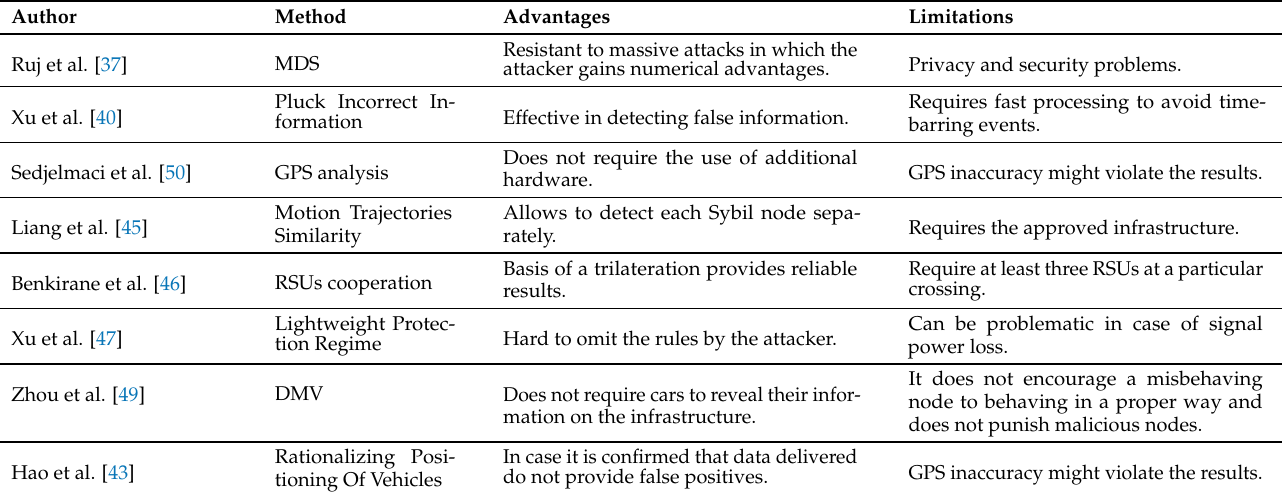
Table 2. Comparison of current Sybil prevention